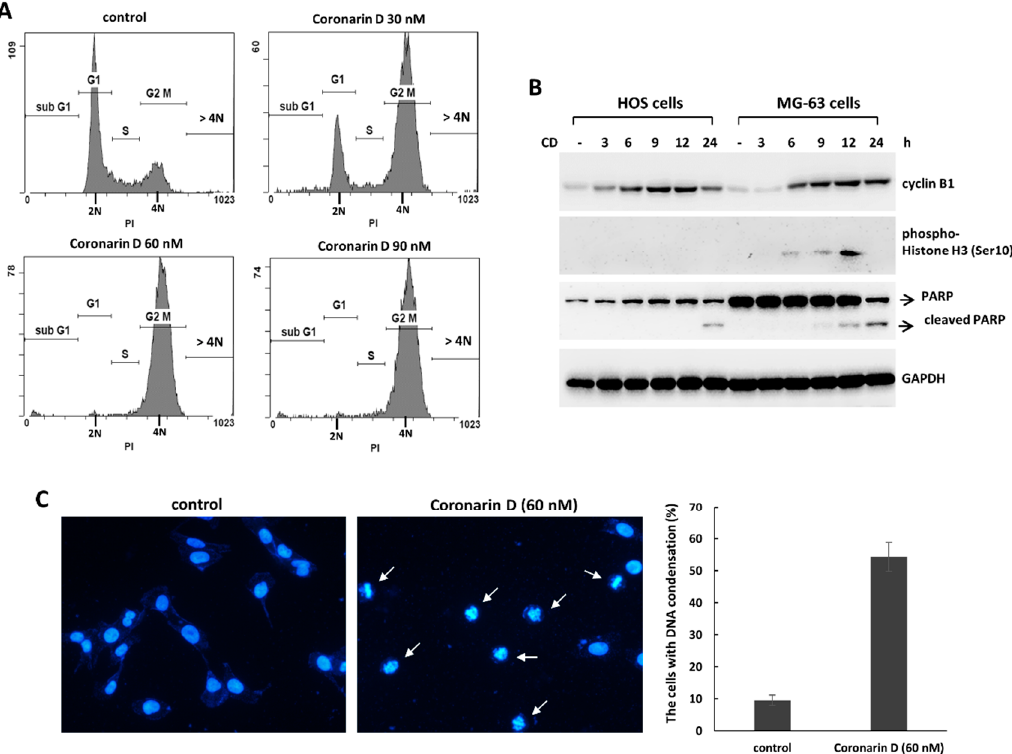
Figure 3. Coronarin D induces M phase arrest in osteosarcoma cells. HOS cells were treated with indicated concentrations of coronarin D for 12 h. The cells were stained with propidium iodide and analyzed by flow cytometer ( A ). ( B ) Coronarin D induces the accumulation of mitosis phase marker in osteosarcoma cells. HOS cells and MG-63 cells were treated with coronarin D (60 nM). The treated cells were harvested in the indicated time points, and analyzed by Western blotting. ( C ) Coronarin D induced DNA condensation in HOS cells. HOS cells were treated with coronarin D (60 nM) for 6 h. The cells were stained with 4,6-diamidino-2-phenylindole (DAPI) for labeling nucleus (blue color), and mitosis cells (white arrows) were observed under microscopic analysis.